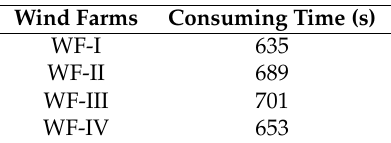
Table 6. Comparison of the consuming time with four wind